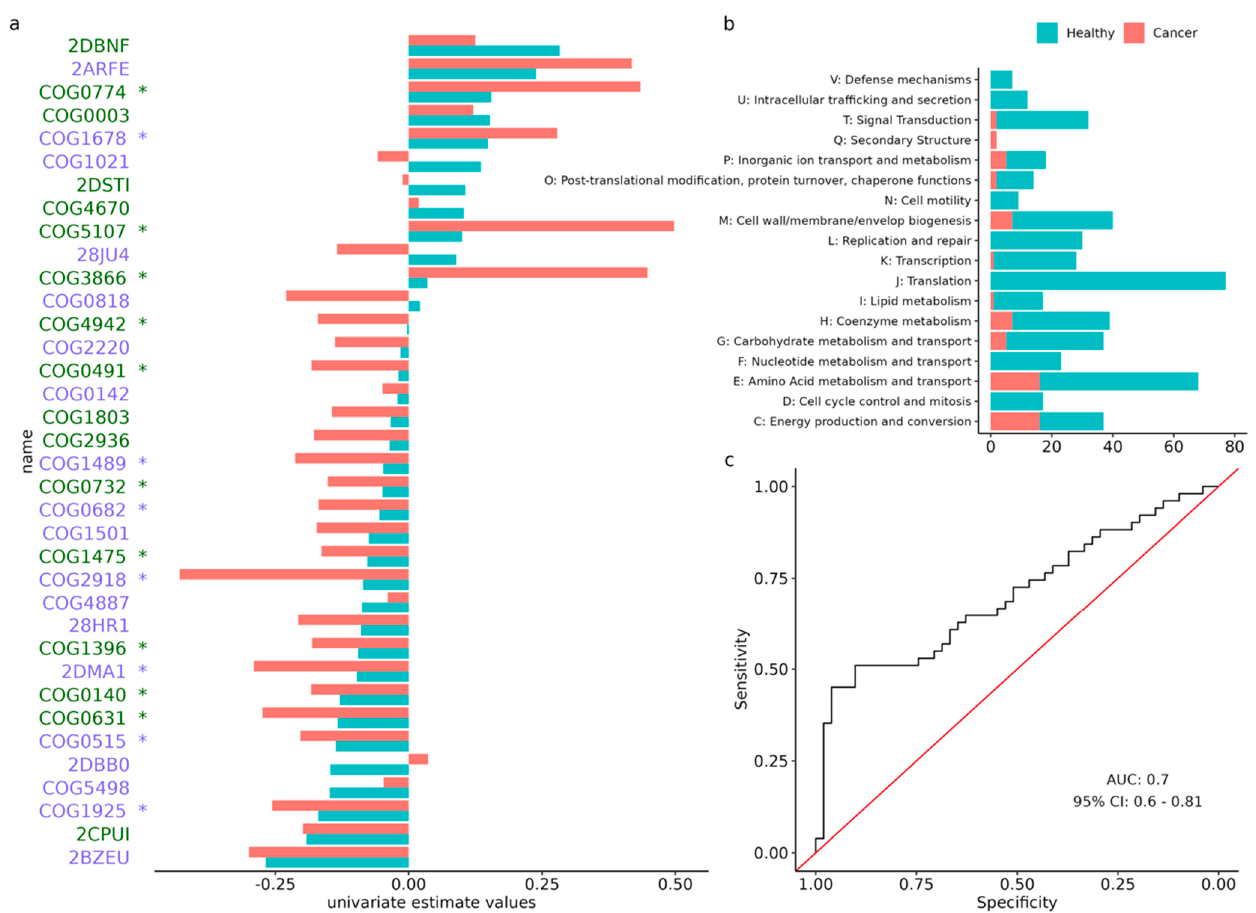
Figure 4. Analysis of eggNOG orthologous group. ( a ) Training (blue) and validation (red) estimate values for each control-enriched (green) and cancer-enriched (purple) species that was selected by the model. ( b ) Amount of significantly associated orthologous groups, clustered by general category. Blue represents the control-associated groups, while red represents the cancer-associated groups. Category “S” (function unknown) was excluded. Orthologous groups belonging to more than one category were counted for each. ( c ) The receiver operating characteristic curve representing the performance of the predictive model. *: statistically significant ( p -value < 0.05) based on Wilcoxon rank sum test in aldex.ttest .